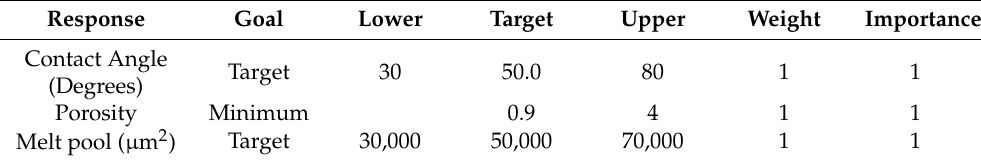
Table 6. Parameters set for response